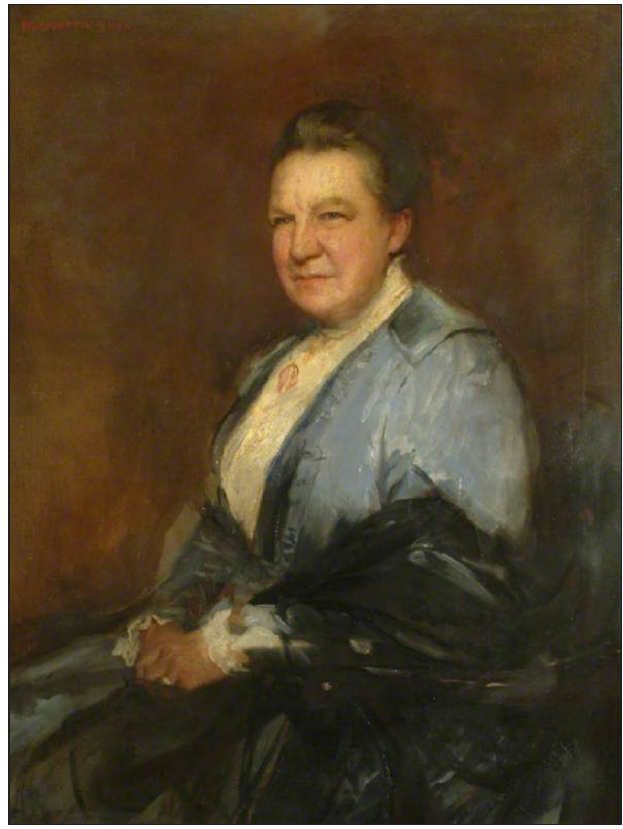
Fig. 6 : Percy Bigland, Miss Henrietta Busk , 1884, oil on canvas, 101.6 × 76.2 cm, Royal Holloway, University of London,